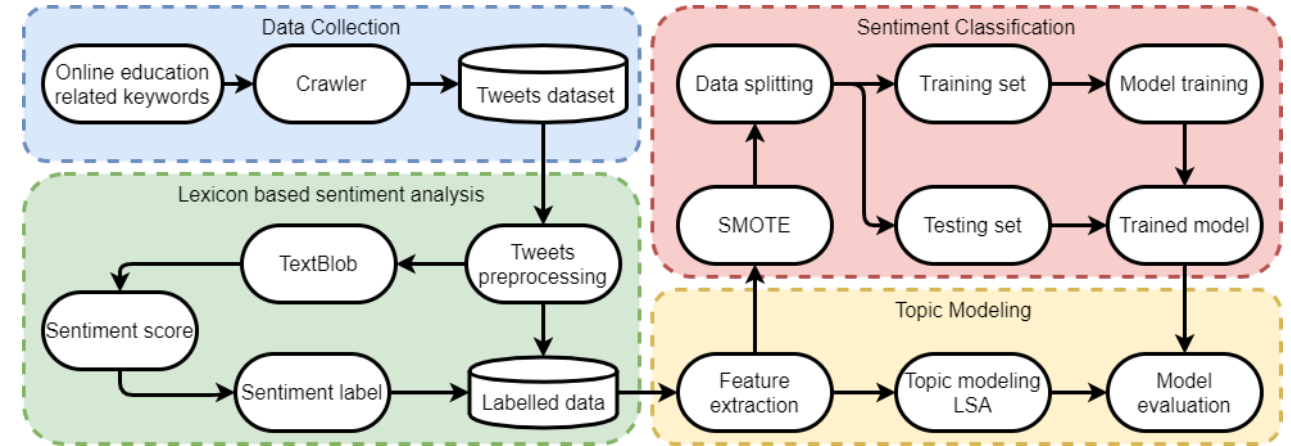
Figure 1. Architecture of the proposed